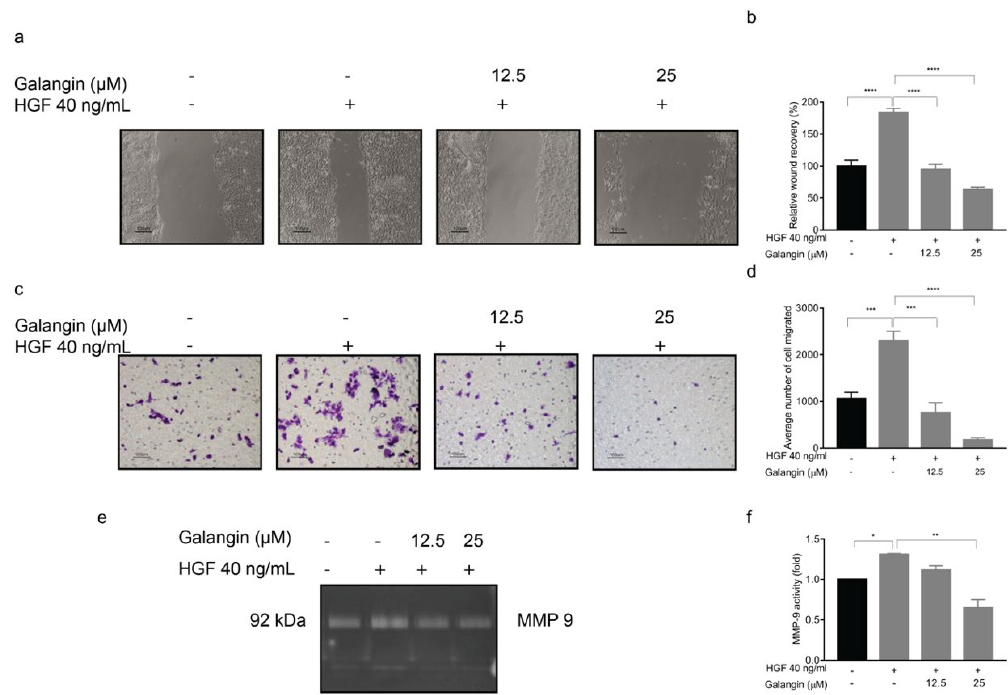
Figure 7. Effect of Galangin upon HGF-stimulation on wound-healing, cell migration, and MMP-9 activity in KKU-213 CCA cells. KKU-213 cells were stimulated with HGF and treated with various concentrations of Galangin. Representative images of ( a ) wound-healing and its ( b ) quantitation. Representative images of ( c ) Transwell cell migration and its respective ( d ) quantitation. Representative images of ( e ) MMP-9 activity and ( f ) its quantitation. Data are the mean ± SEM from three independent experiments, * p ≤ 0.05, ** p ≤ 0.01, *** p ≤ 0.001, **** p ≤ 0.0001 compared with the HGF